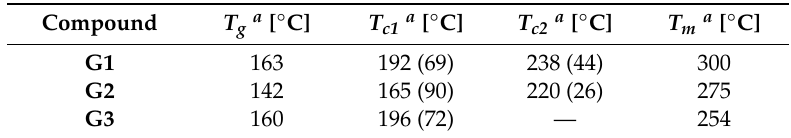
Table 2. Mesophase assignment and transition temperatures, ◦ C (onset) a of dendritic architectures. Glass-transition ( T g ), Crystallization ( T c ), and Melting ( T m ) temperatures of G1 , G2 and G3 compounds (transition enthalpies between parenthesis; J g − 1 ).